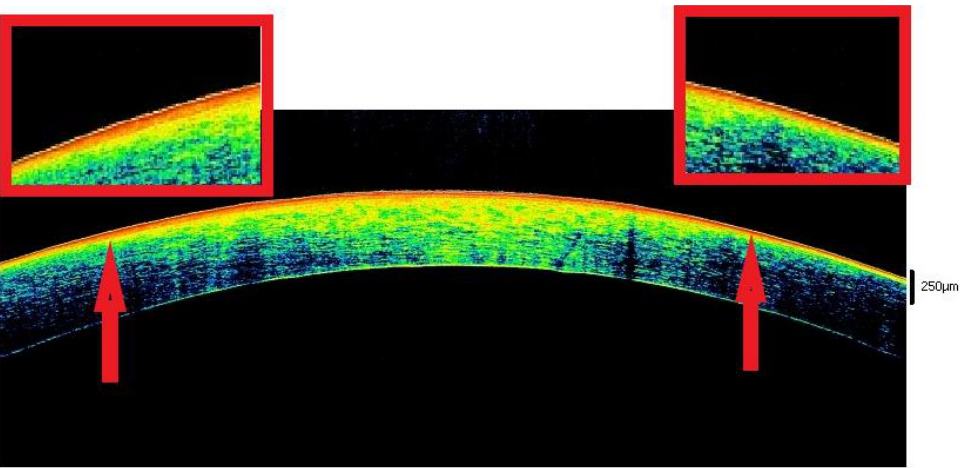
Figure 3. Binary sign. In open eyes, the phenomena of dehydration lead to the drying of the tear film (outer line of hyper-reflectivity). At the same time the appearance of hyper-reflectivity in the anterior surface of the cornea can be observed (inner line of hyper-reflectivity). These phenomena favor the formation of the typical “ binary ” pattern (indicated by red arrows) that characterizes all corneas exposed to the environment in the interval between the third and sixth hour.